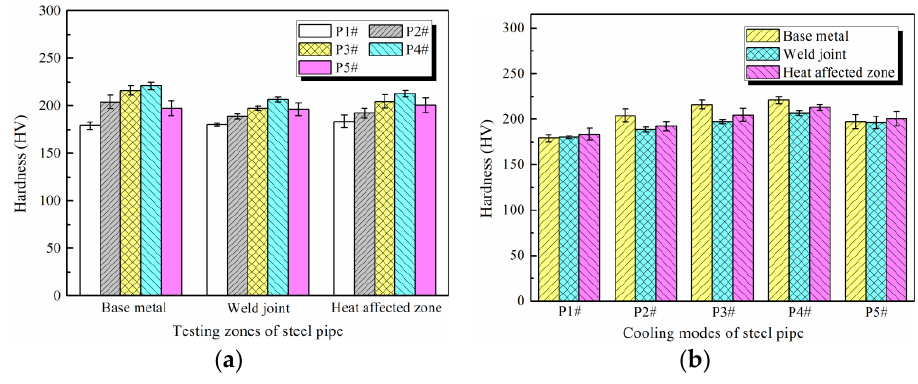
Figure 6. Hardness distribution of steel pipes ( a ) comparison of different processes; and ( b ) comparison of different zones.